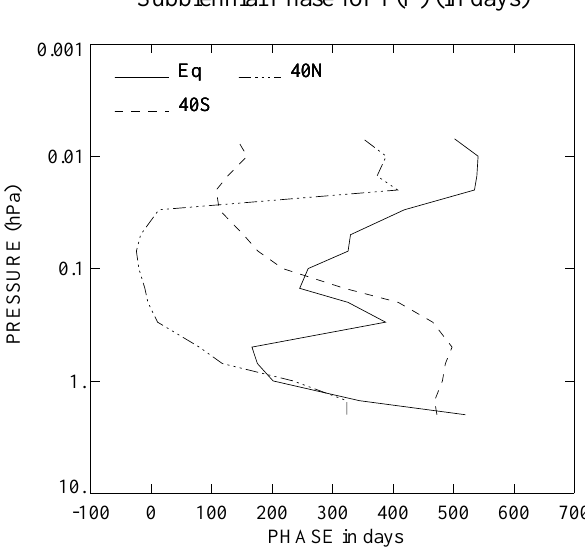
Fig. 13. Profiles of the relative phases for the subbiennial terms at selected latitudes.